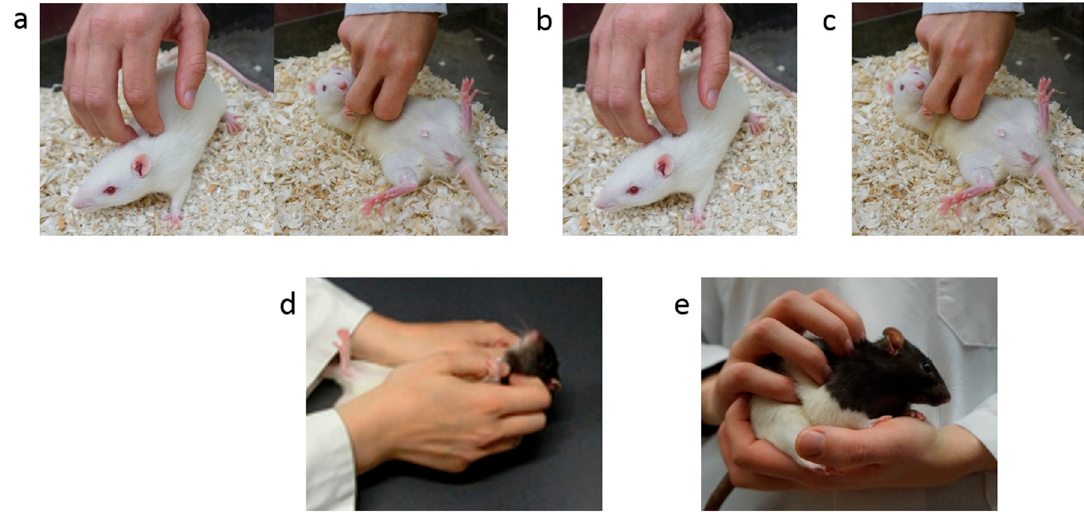
Figure 2. Pictorial tickling procedures. ( a ): Dorsal contact and pin (standard, validated rat tickling procedure), ( b ): Dorsal contact only or stroking in the cage, ( c ): Pin only, ( d ): Two-handed pin only, ( e ): Stroking in the hand.